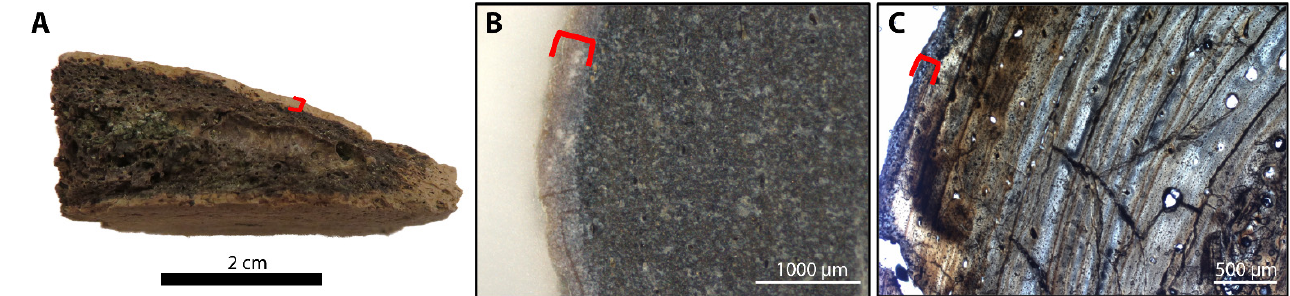
Figure 2. Examples of the two bone colors observed in specimens from EFP: an outer rim of light- colored bone (indicated by red brackets) and a darker interior. ( A ) Hand sample of a bone fragment from EFP. Note the light-coloration of the lower surface of the bone (directly above the scale bar). ( B , C ) Thoracosaurus neocesariensis femur (RU-EFP-00006-11) in ( B ) thick section and ( C ) thin section. Images ( B , C ) are not from the same position along the circumference of this bone, and the light-colored rim is not a consistent thickness along the entire circumference. Scale bars as